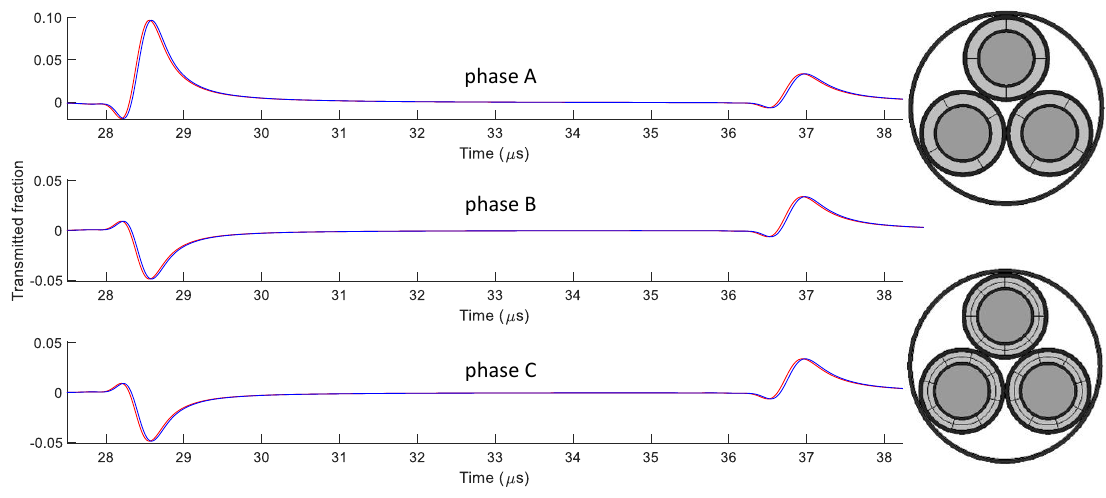
Figure 9. Waveforms arising on the phase conductors for a balanced current distribution, modeled with 4 (blue waveform, inset at top) and 16 (red waveform, inset at bottom) XLPE segments around each phase conductor; first subfigure belongs to the conductor with signal injection (phase A).